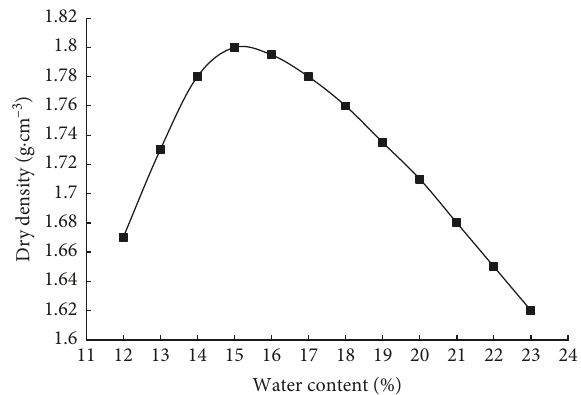
Figure 3: Relationship curve between dry density and water